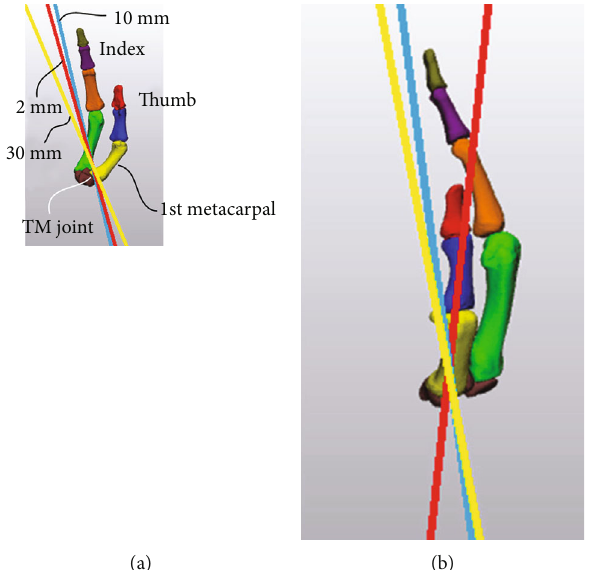
Figure 5: The rotation axes of the 1st metacarpal when pinching cylinders with 2, 10, and 30 mm diameters. (a) Volar view and (b) lateral